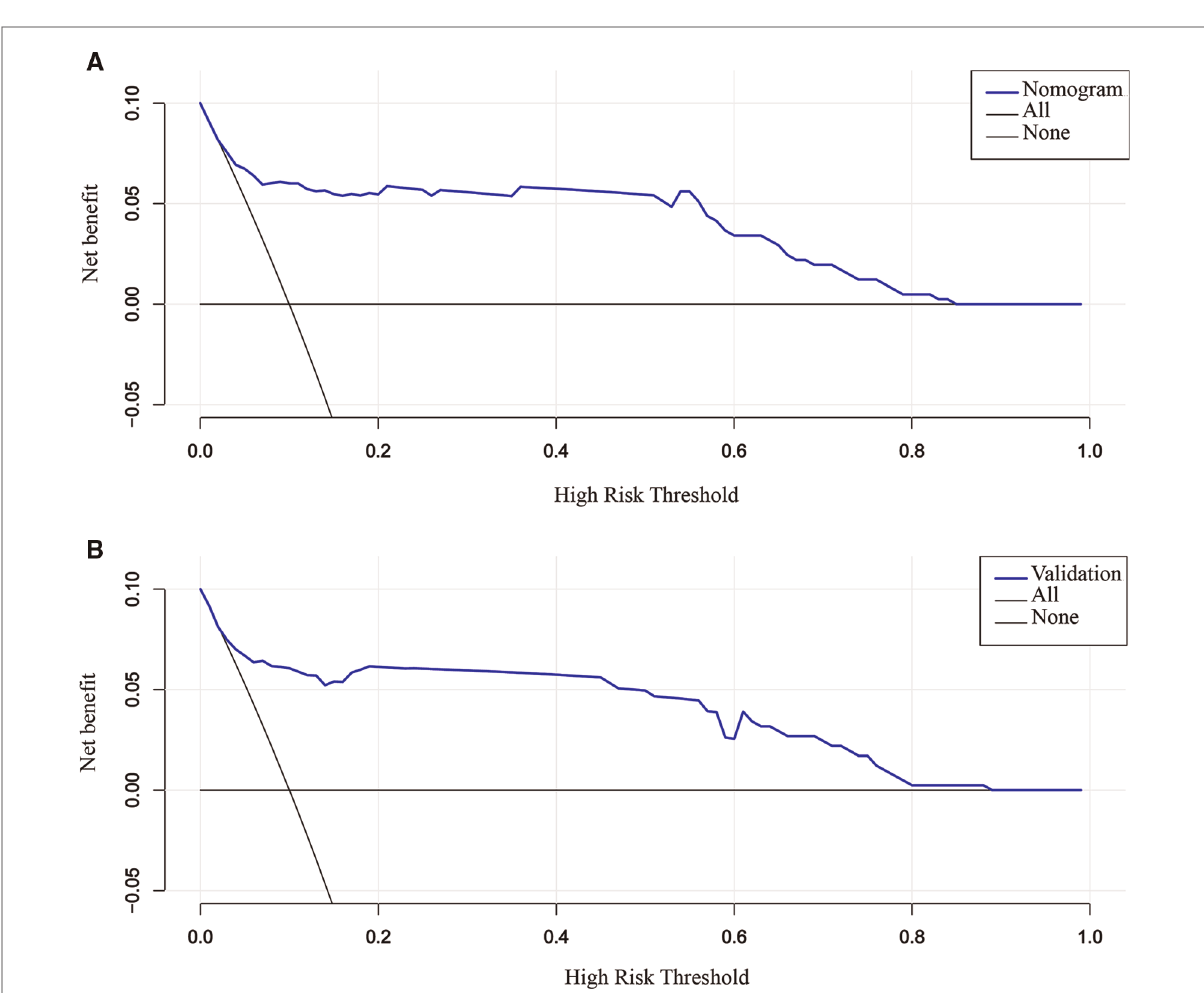
FIGURE 6 DCA for the evaluation of the clinical applicability of the nomogram. The blue line represents the net bene fi t. Both in the training ( A ) and validation cohort ( B ), the nomogram yields clinical net bene fi ts when the threshold probability is between 10% and 85%. These results indicate good potential for clinical utility. DCA, decision curve